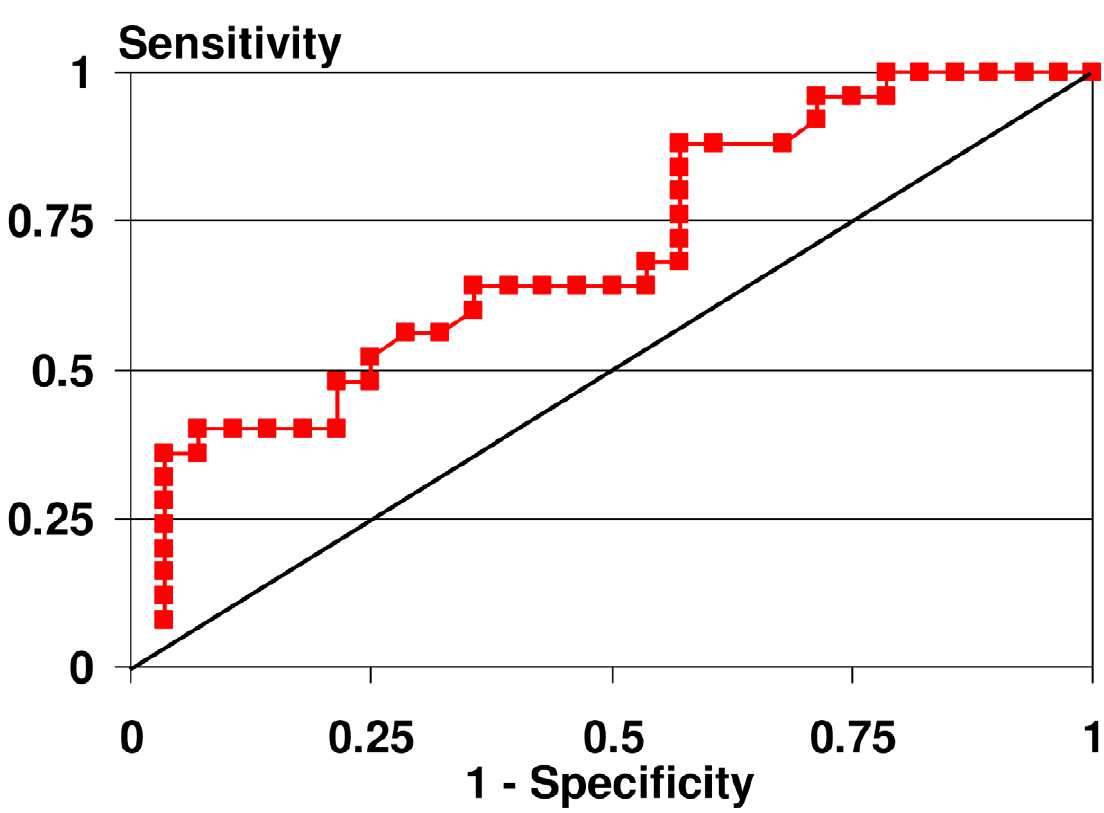
Figure 2. Receiver Operating Characteristic (ROC) curve for tonometry measurement of tissue compressibility of the dominant posterior thigh.